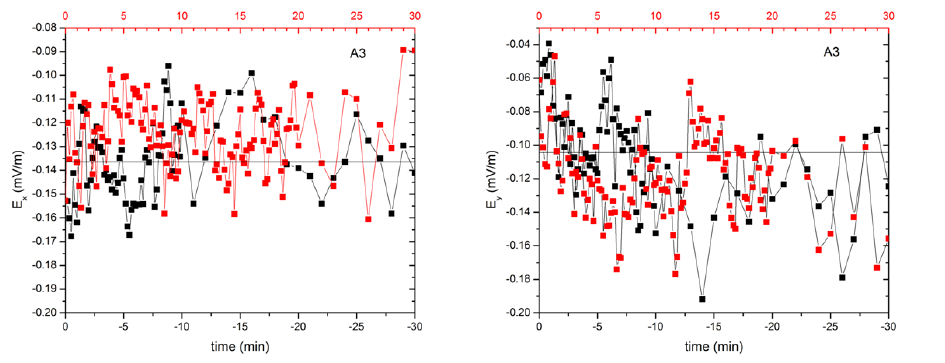
and E (in mV/m), observed along the AB and AC dipoles, respectively, related to the shot in Figure 6. Natural electric field components, E x y A3. Black symbols are used for data measured 30 min before the shot, while red symbols are used for data registered 30 min after the shot. The zero time of both the black and red scales corresponds to the shot time. The black continuous line represents the average value of the field component before the shot.